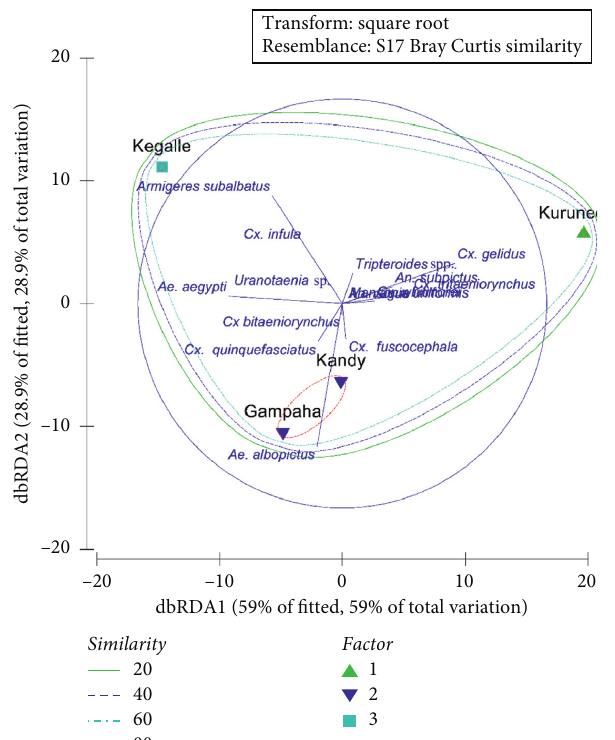
Figure 2: dbRDA plot for distribution of mosquito species in Kurunegala, Kegalle, Gampaha, and Kandy districts, Sri